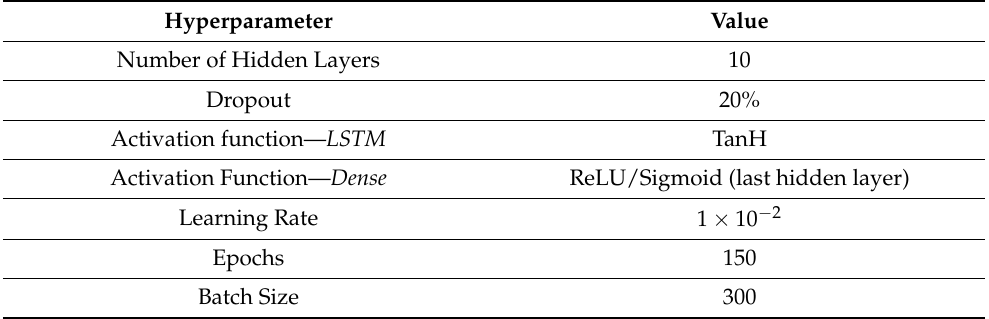
Table 3. LSTM hyperparameters.